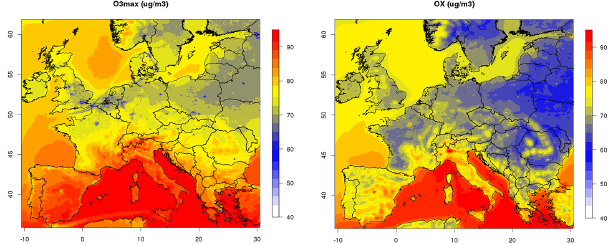
Figure 28. In a continental chemistry transport simulation with the CHIMERE model at a resolution of 8km, major urban centres in northern and central Europe highlight the NO x titration process (left: summertime average of daily maximum ozone), while the to- tal oxidant level (right: O 3 as NO 2 + O 3 , annual mean) is high in most European cities (adapted from Terrenoire et al.,